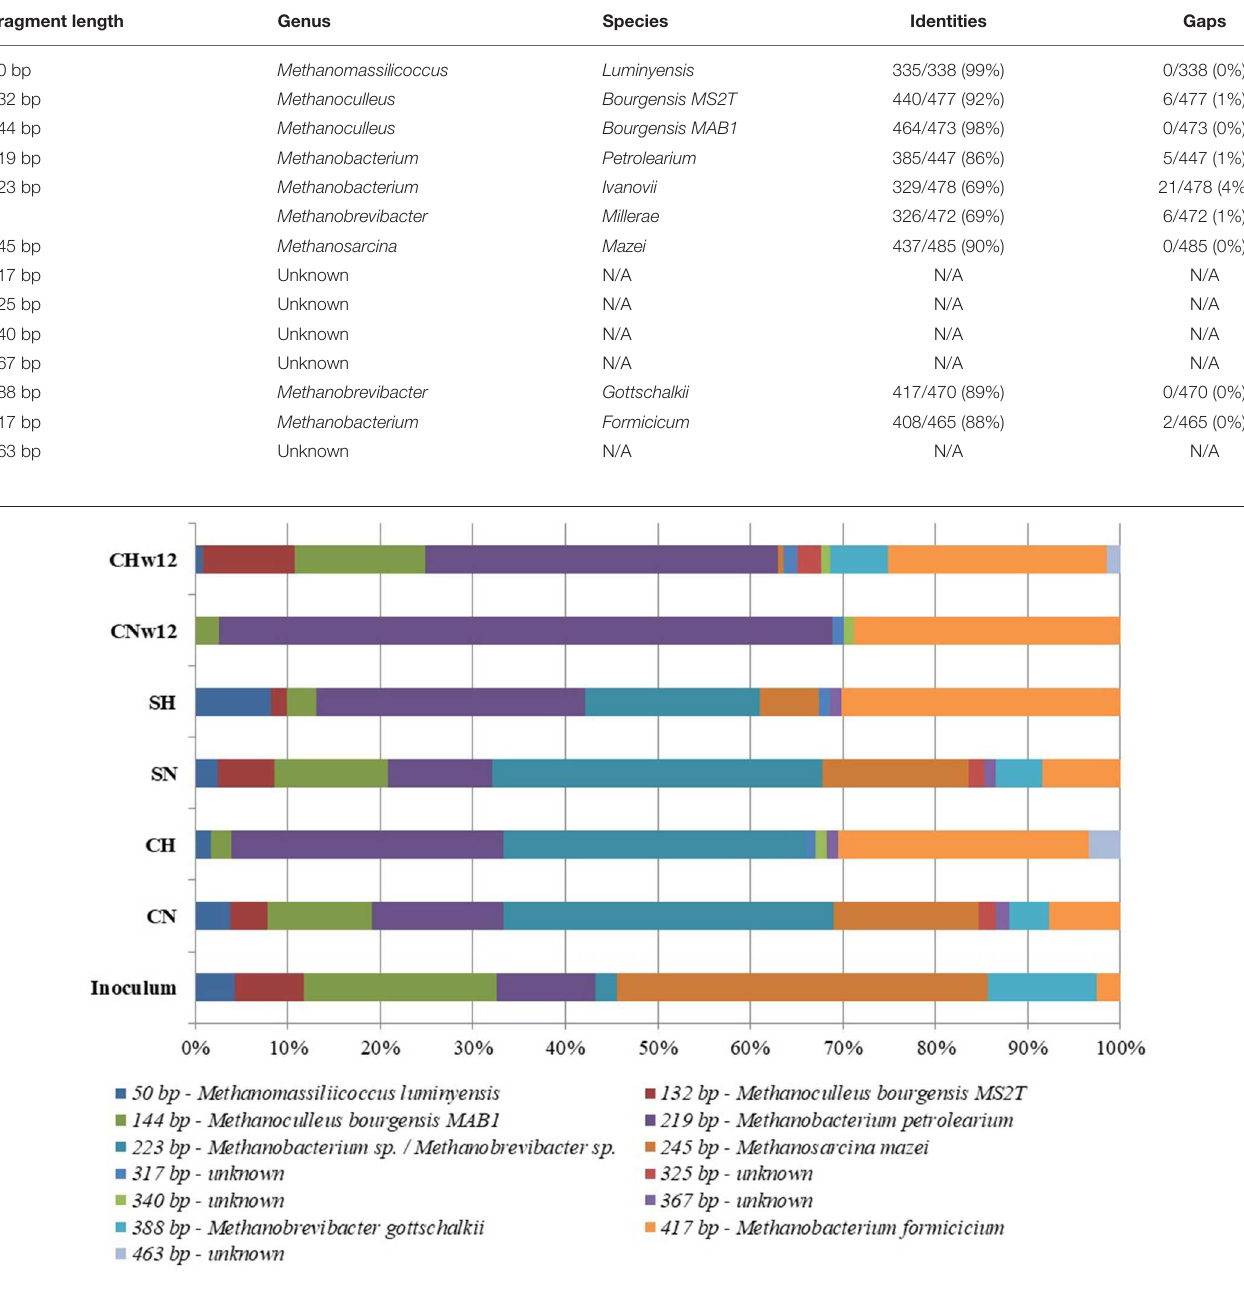
TABLE 3 | Identified clones for the T-RFLP analysis.